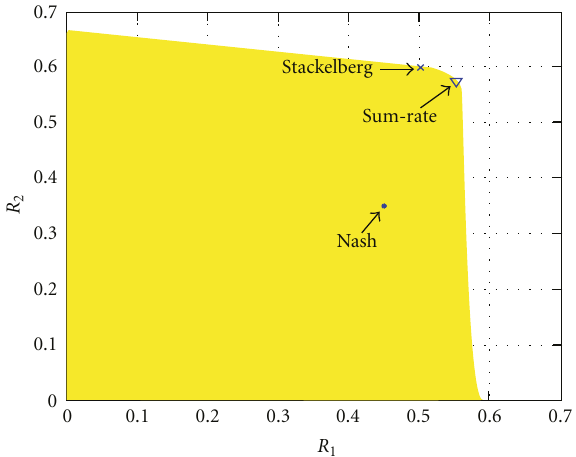
Figure 7: Achievable rate region for the inter-operator spectrum sharing game. Both operators achieve better payo ff s when adopting the hierarchical (Stackelbeg) approach.